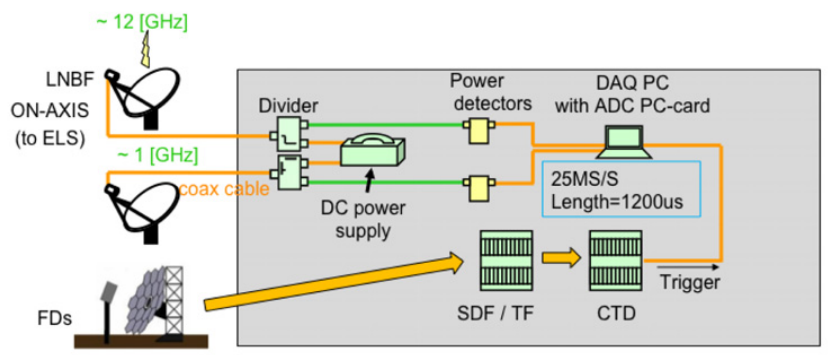
Figure 4. The experimental setup at the Telescope Array